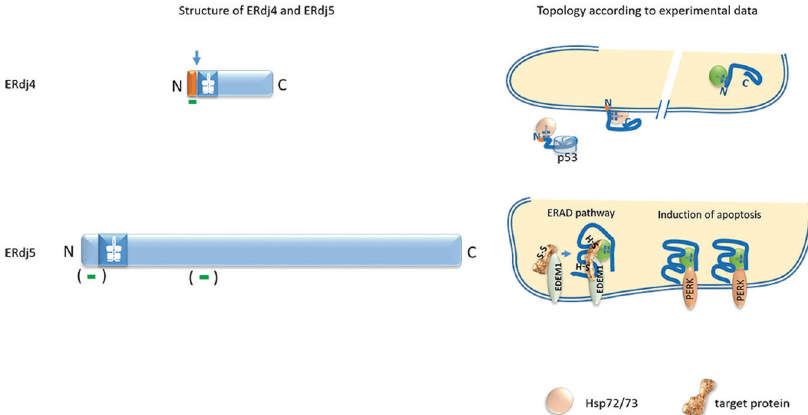
Fig. 3 Structure and topology of ERdj4 and ERdj5. Upper line: ERdj4 is a small protein with a predicted size of 25.7 kDa, a signal peptide (80% probability), the cleavage of which is calculated with a probability of 70%. As for ERdj3, the signal sequence contains the hydrophobic region addressed as the transmembrane domain. Cleavage of the signal sequence (arrow) accordingly results in a “ free- fl oating ” protein, either in the lumen of the ER or in the cytosol. The major pool of ERdj4 protein is cleaved and located in the luminal compartment of the ER. A minor pool exists as an uncleaved transmembrane protein. Increasing evidence points to a cytosolic orientation or even a cytosolic pool that can shuttle to the nucleus. Lower line: Computational analysis of ERdj5 predicts no signal sequence but two transmembrane domains. Experimental data do not con fi rm the existence of transmembrane domains. ERdj5 seems to be entirely located within the ER lumen, where it interacts with EDEM1 to reduce EDEM1-recruited substrates to enable their degradation via ERAD [61]. Due to its complexing with BiP and PERK, ERdj5 inhibits autophosphorylation of PERK and subsequent phosphorylation of eIF2 α inducing apoptosis as shown in colon cancer cells [63]. Symbols, which are not explained are the same as in Fig.